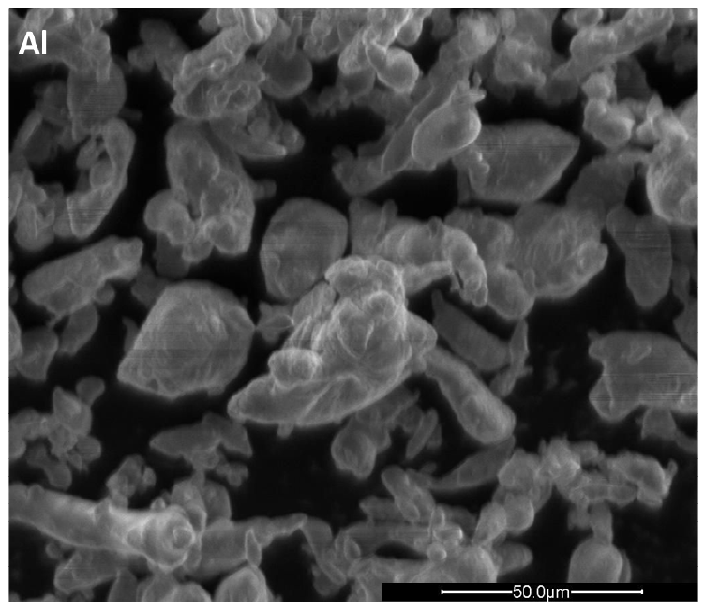
Figure 2. Scanning electron microscope (SEM) image of the aluminum particles (typical size 15–20 microns) used as a water-reactive component of the fuel grain.